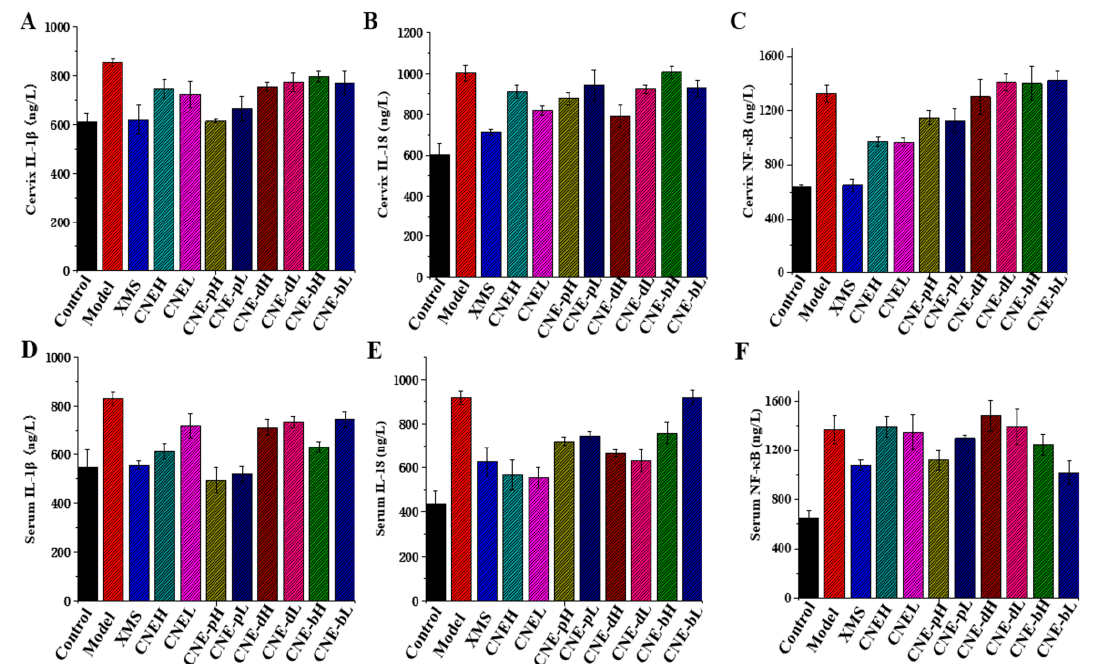
Figure 7. Changes of inflammatory factors in SD rats treated with different extracts obtained from C. nudiflora (CNE, CNE-p, CNE-d, CNE-b). The levels of inflammatory factors in the cervix and serum were detected by ELISA. ( A ) Changes in cervical IL-1 β levels after treatments with different extracts. ( B ) Changes in cervical IL-18 levels after treatments with different extracts. ( C ) Changes in cervical NF- κ B expression after treatments with different extracts. ( D ) Changes in serum IL-1 β levels after treatments with different extracts. ( E ) Changes in serum IL-18 levels after treating with different extracts. ( F ) Changes in serum NF- κ B levels after treating with different extracts.